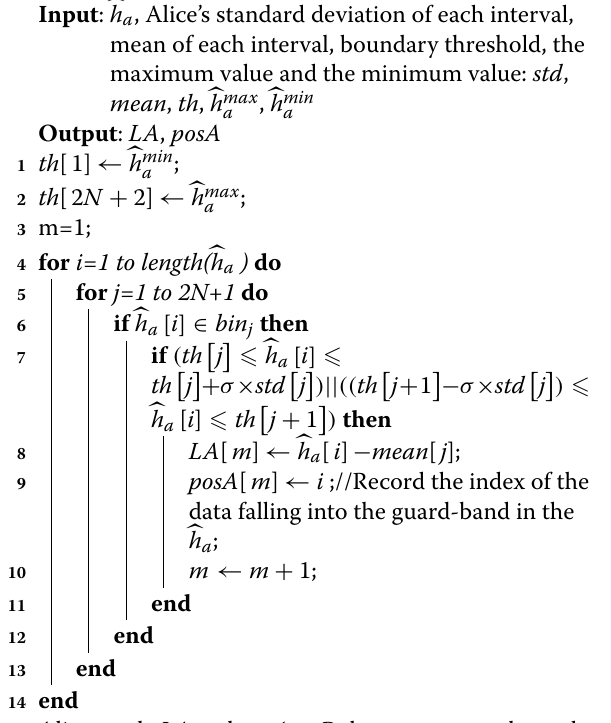
Algorithm 1: Find the measurements to be corrected